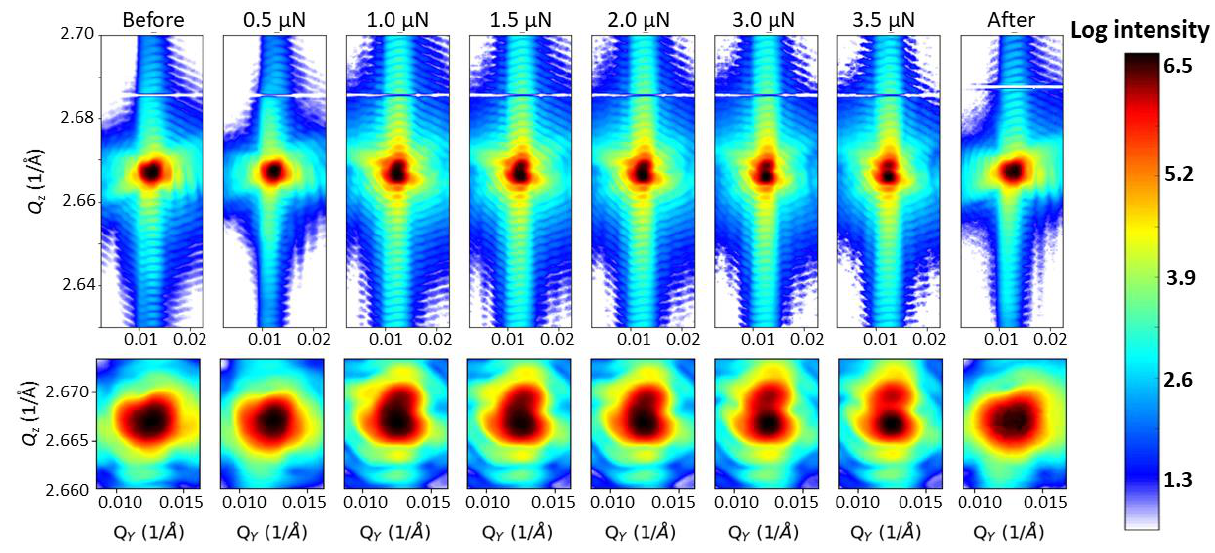
Figure 3. In situ mw-BCDPs integrated along Q x of the Au 111 Brag reflection recorded during the nano-indentation of a strain-free and defect-free Au crystal. The lower row shows a closeup of the central part of the Au 111 Bragg peak shown in the upper